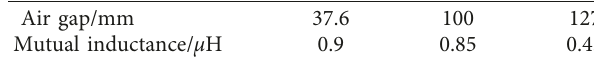
Table 1: Mutual inductance values at different air gaps.